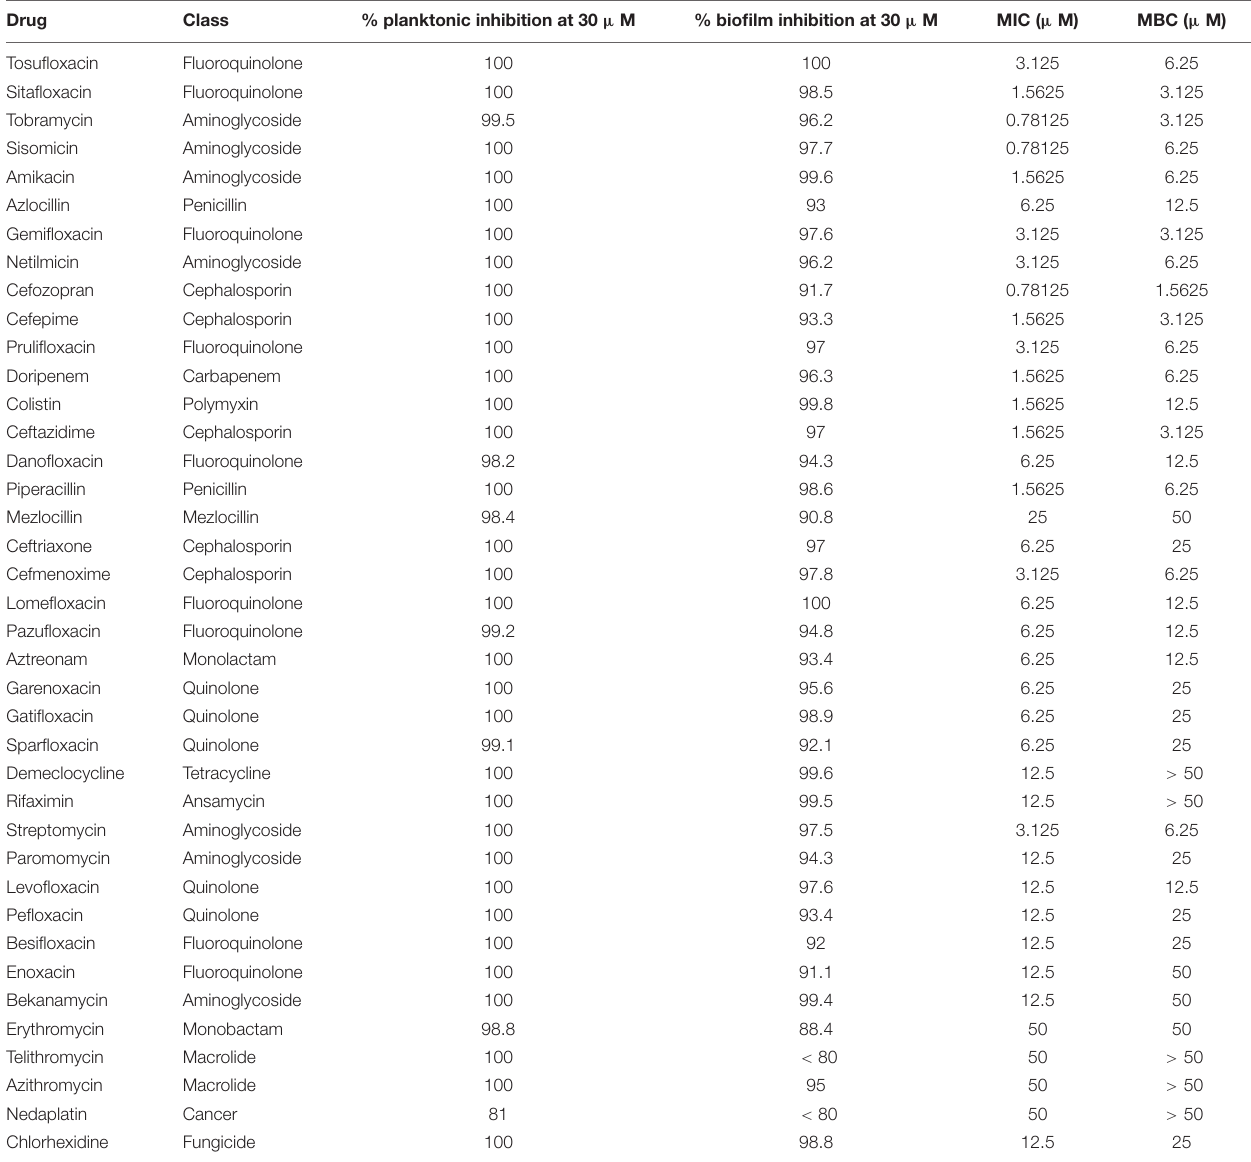
TABLE 1 | Drugs with activity against P. aeruginosa PAO1 planktonic and